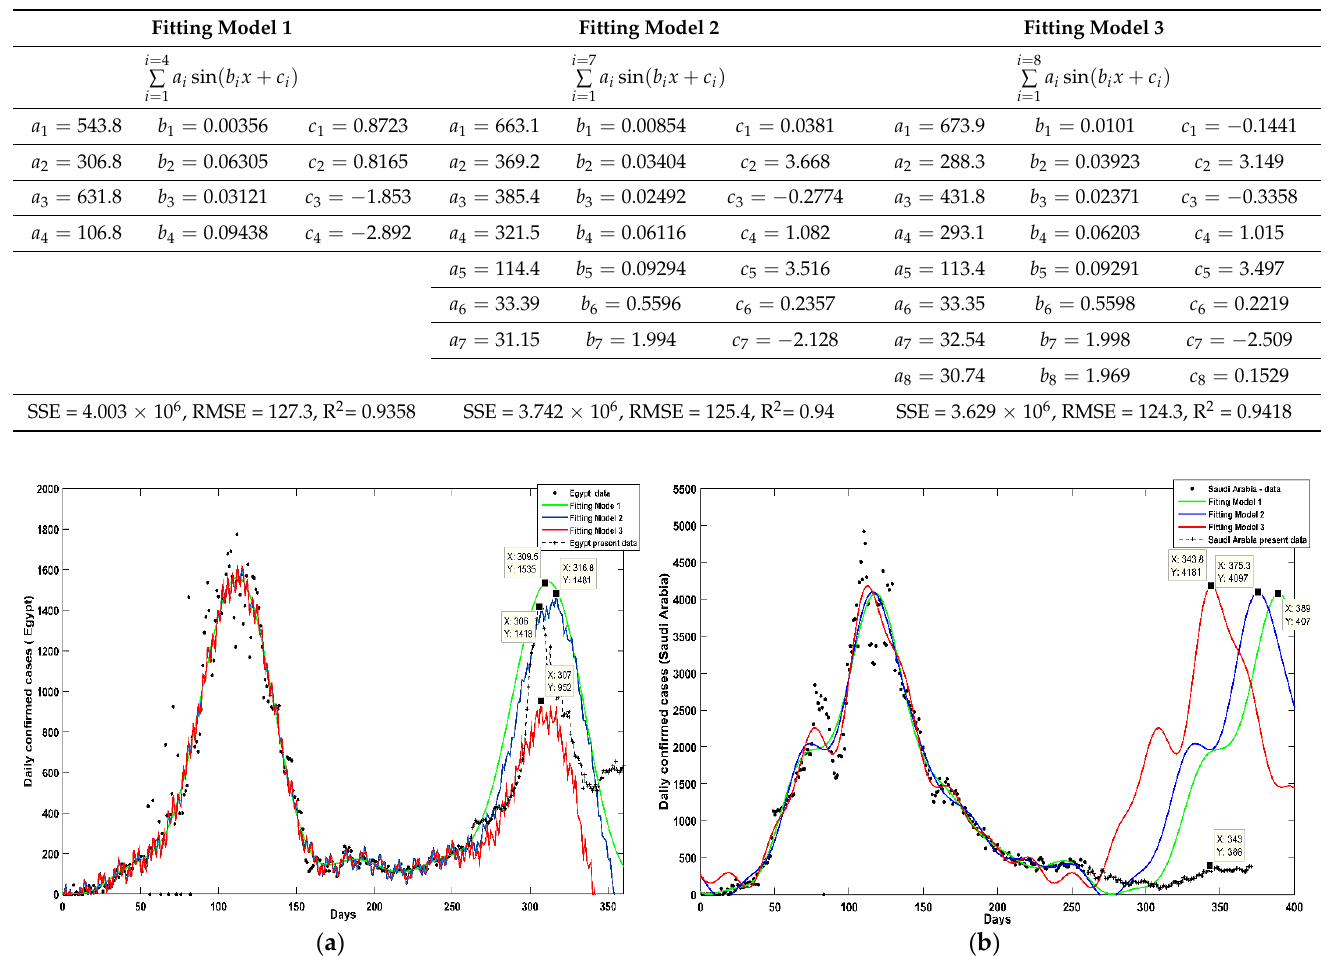
Table 3. Actual vaccinated people in first category countries [14].